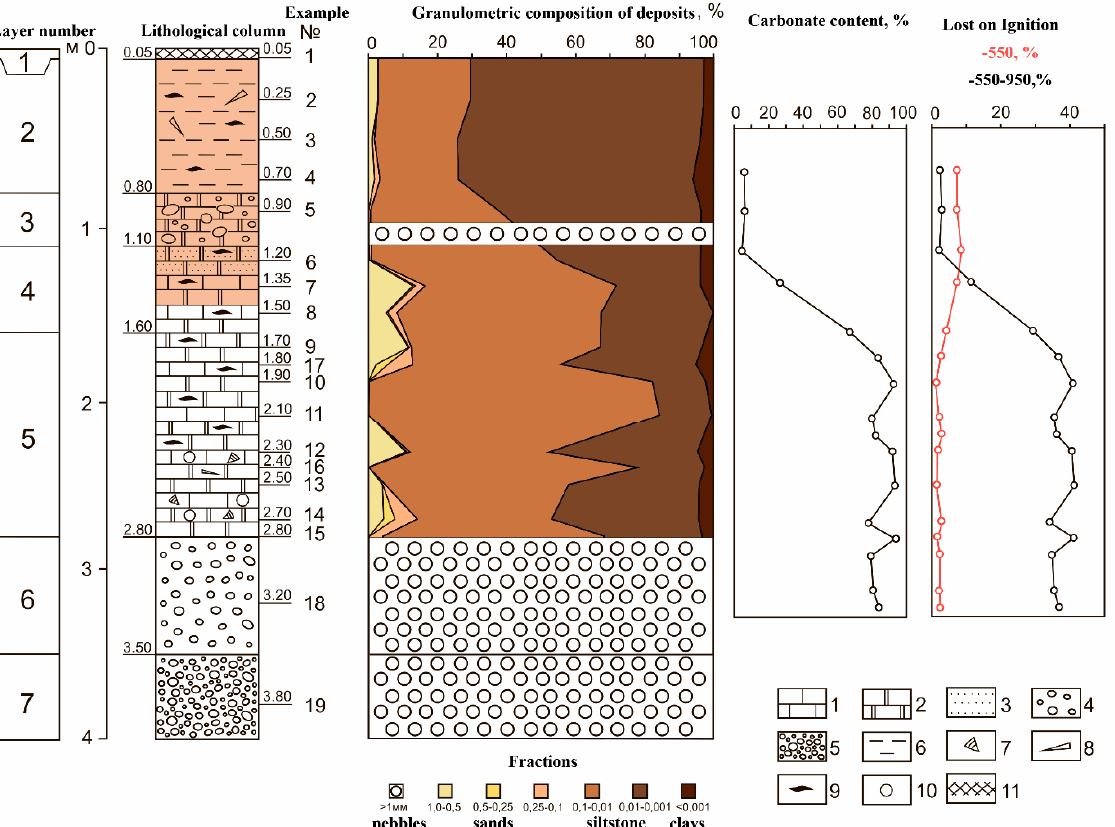
Figure 12. The structure and composition of the section of sedimentary rocks found in Cape Bombora: 1. calcite; 2. dolomite; 3. sand; 4. loose pebbles; 5. dense pebbles; 6. siltstone; 7. shell detritus; 8. fragments of lime microorganisms; 9. fragments of plant tissue; 10. carbonate concretions; 11. sod layer. Loss on Ignition (LOI) curve No. 550 indicates the amount of combustible organics, No. 950 shows the amount of carbonate minerals that release carbon dioxide at specified temperatures.